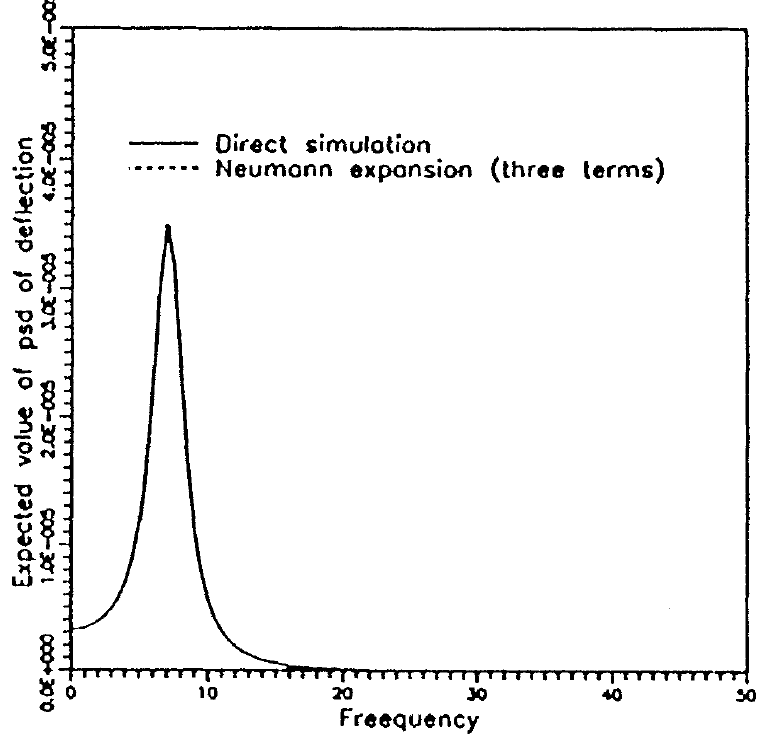
Fig. 3. Expected value of the psd of deflection at node 46 of the plate (c.o.v. =